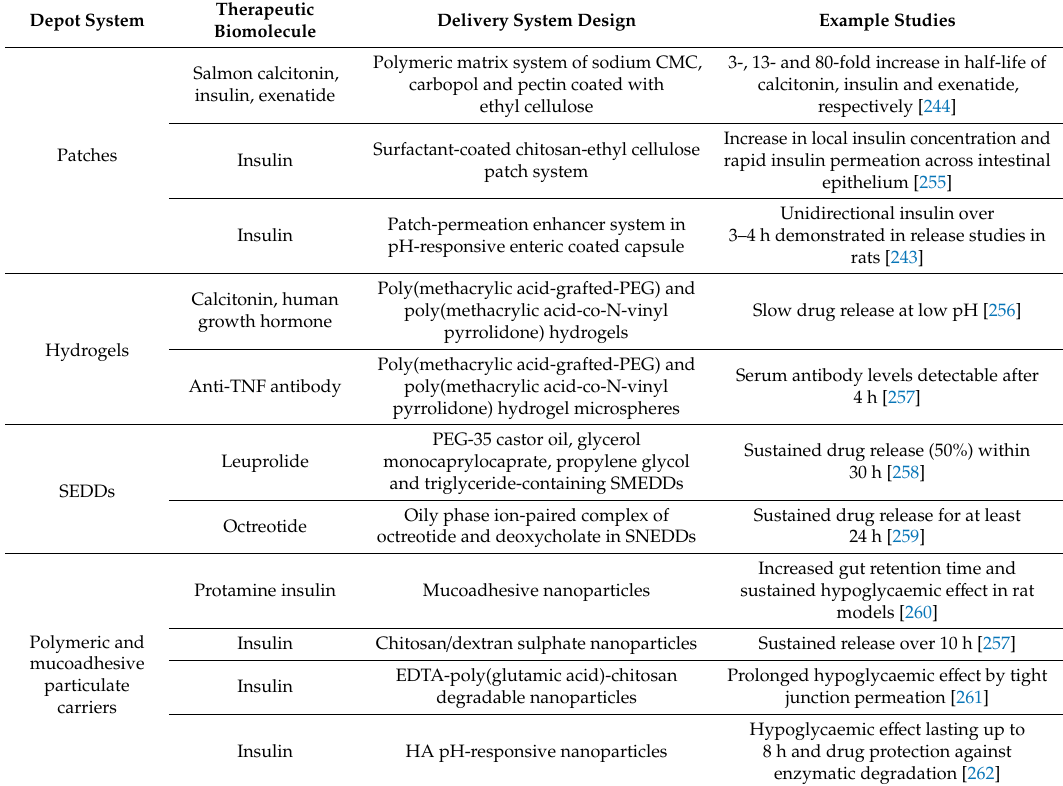
Table 3. Formulation strategies for the delivery of polypeptides via the oral